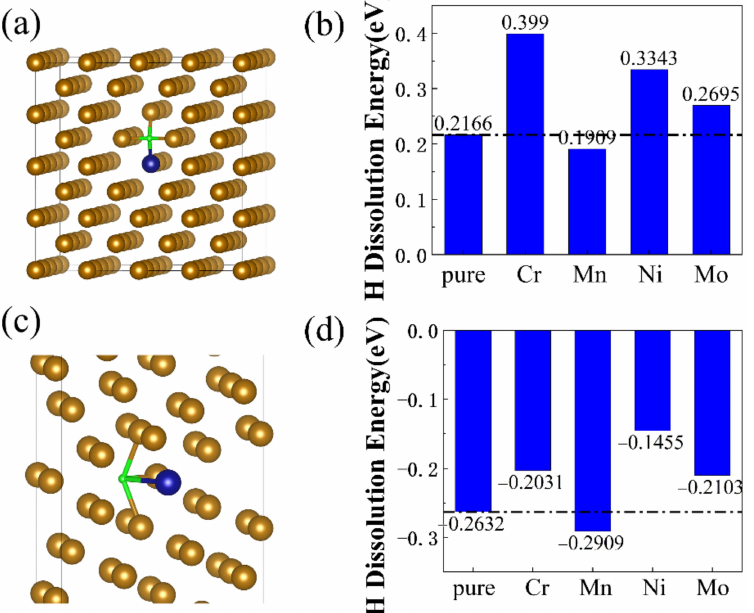
Figure 4. ( a ) doped bcc-Fe bulk structure with H, ( b ) H dissolution energies of doped bcc-Fe bulk structure; ( c ) doped bcc-Fe Σ 5 GB with H; ( d ) H dissolution energies of doped bcc-Fe Σ 5